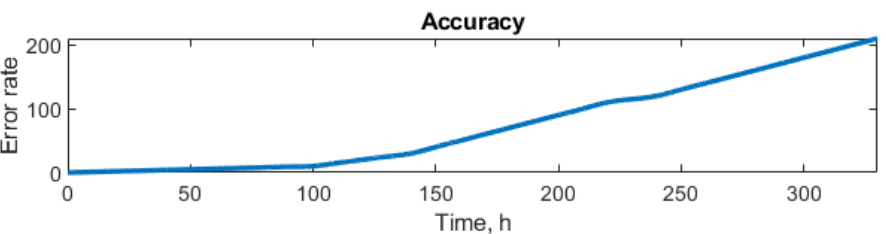
Figure 7. The circumstances 32 kB.